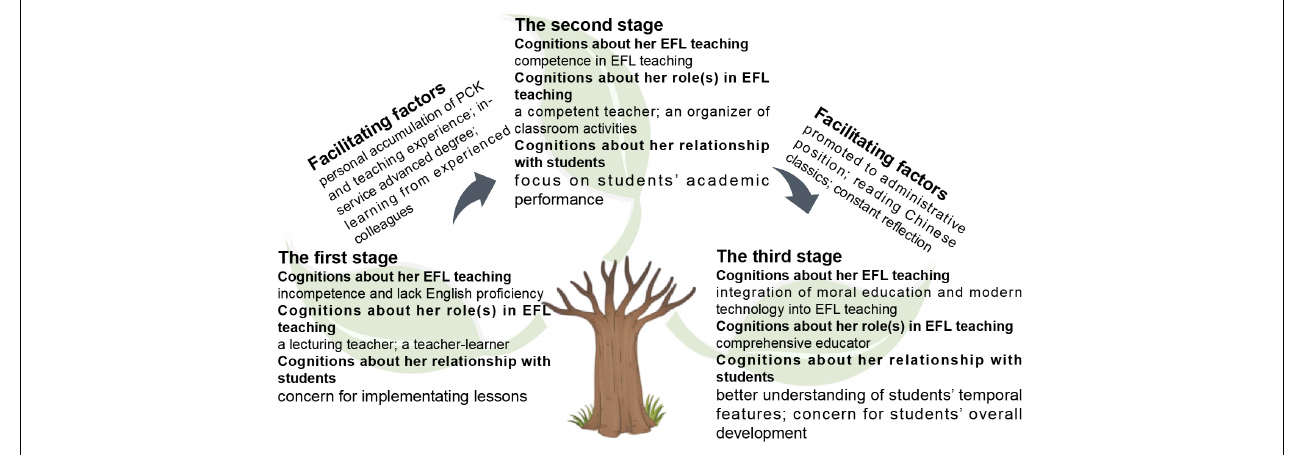
FIGURE 1 | The trajectory of Jennifer’s professional development as an EFL